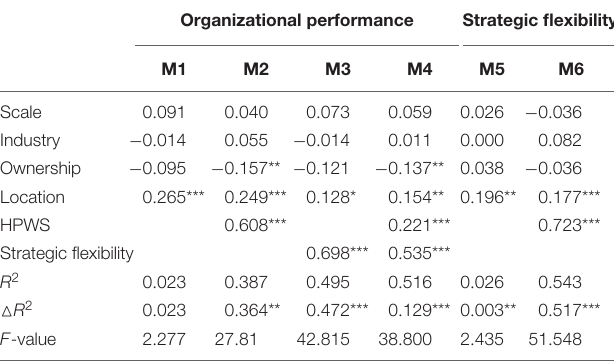
TABLE 3 | Test of the mediating role of strategic